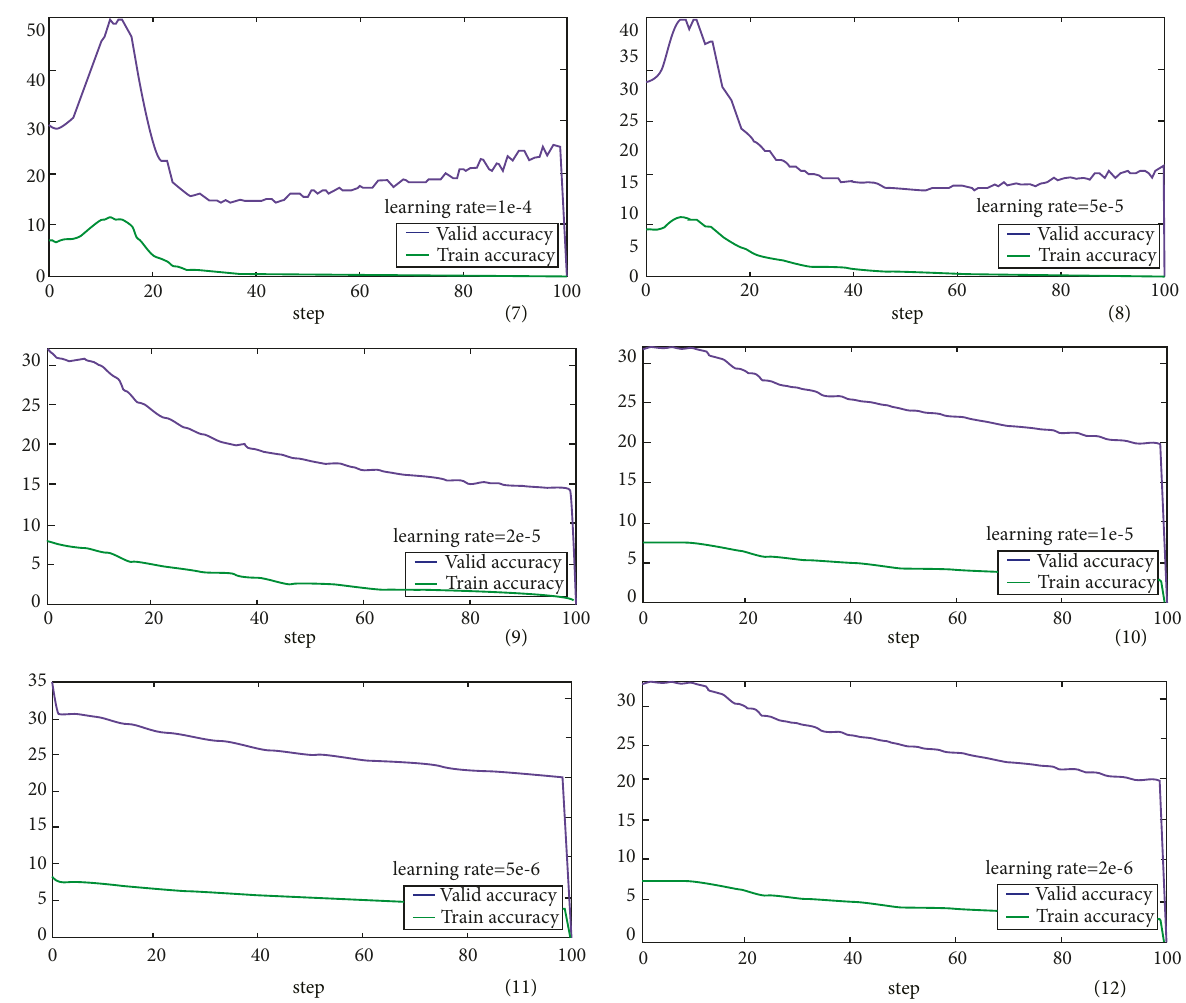
Figure 14: Changes of loss function under different learning rates in training process (2).